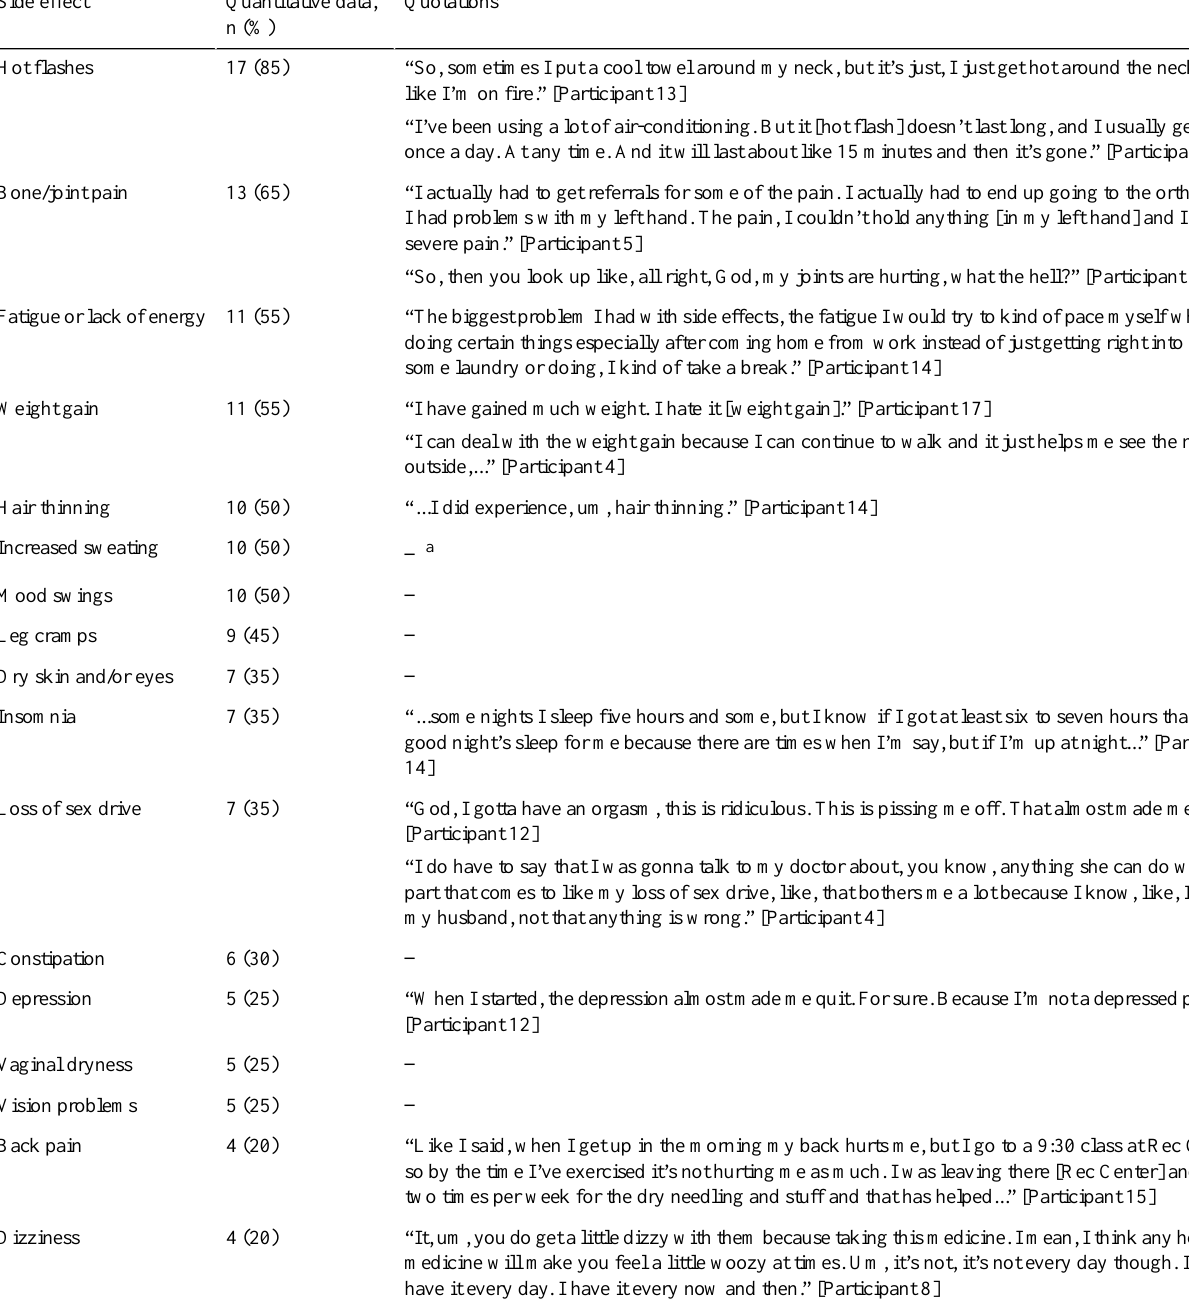
Table 3. Self-reported endocrine therapy side